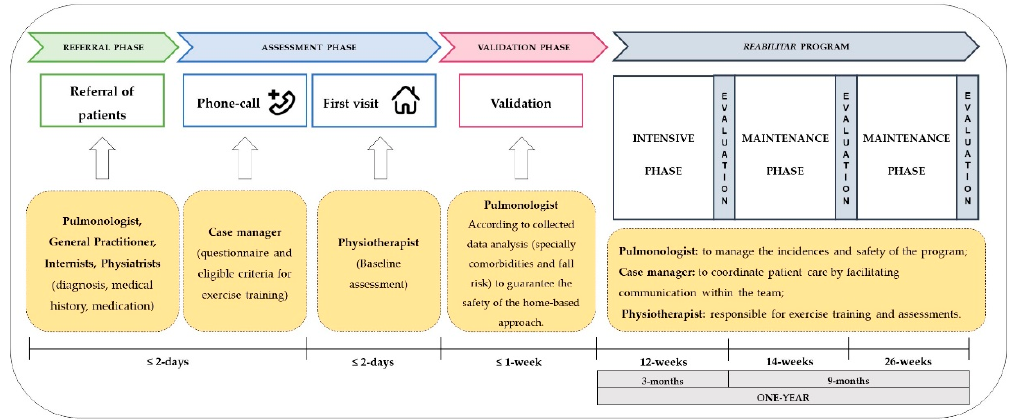
Figure 4. Overview of the timeline and procedures of the reabilitAR program.